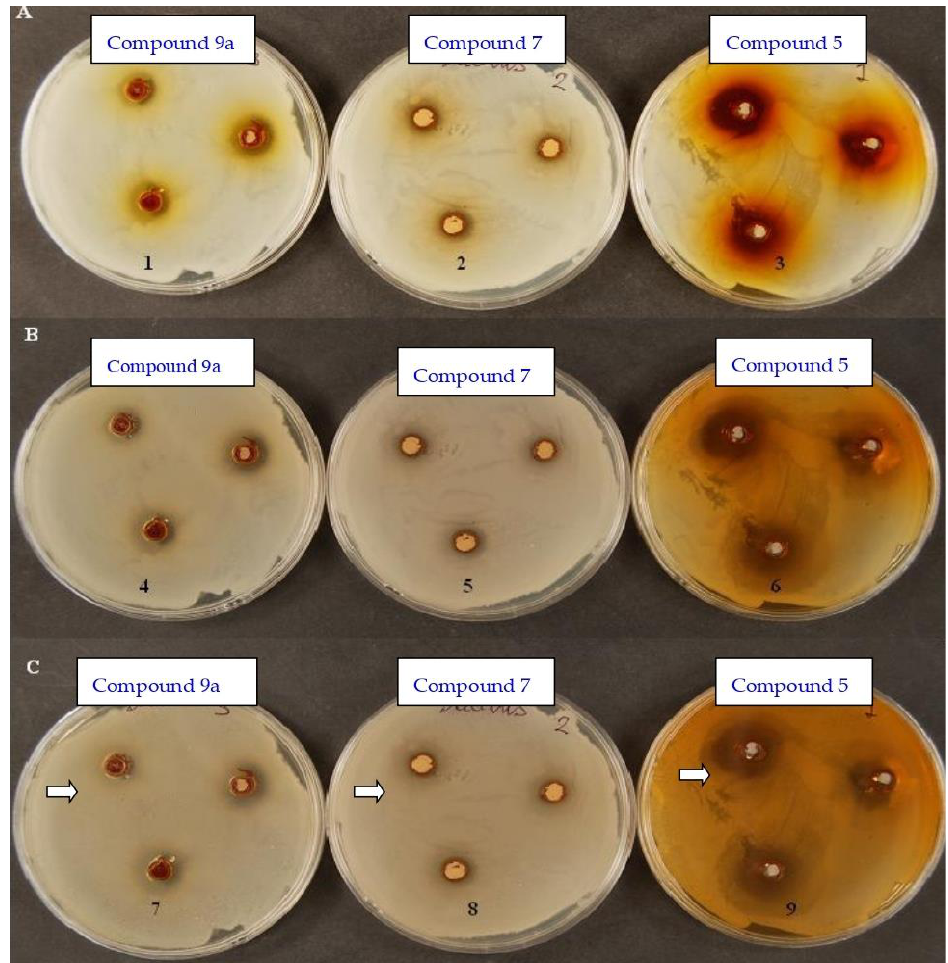
Figure 13. Bacillus subtilus treated with 10mg ml −1 of dyes 5, 7, and 11a after one day ( A ) (1, 2, 3), Figure 13. Candida albican treated with 10mg ml − 1 of dyes 5, 7, and 9a after one day ( A ) (1, 2, 3), three days( B ) (4, 5, 6) and six days ( C ) (7, 8 ,9) of incubation. three days( B ) (4, 5, 6) and six days ( C ) (7, 8, 9) of